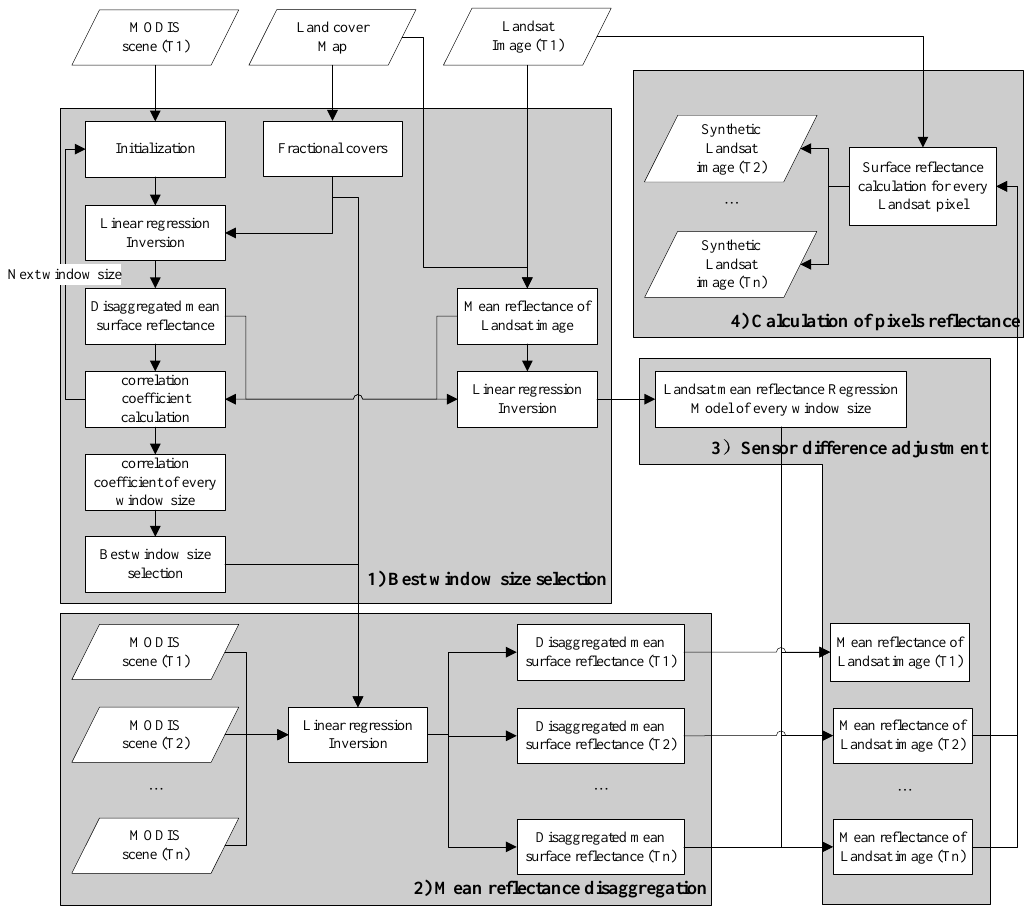
Figure 1. Flowchart of the modified spatial and temporal data fusion approach (MSTDFA) algorithm. The processing steps of the three main blocks are explained in Sections